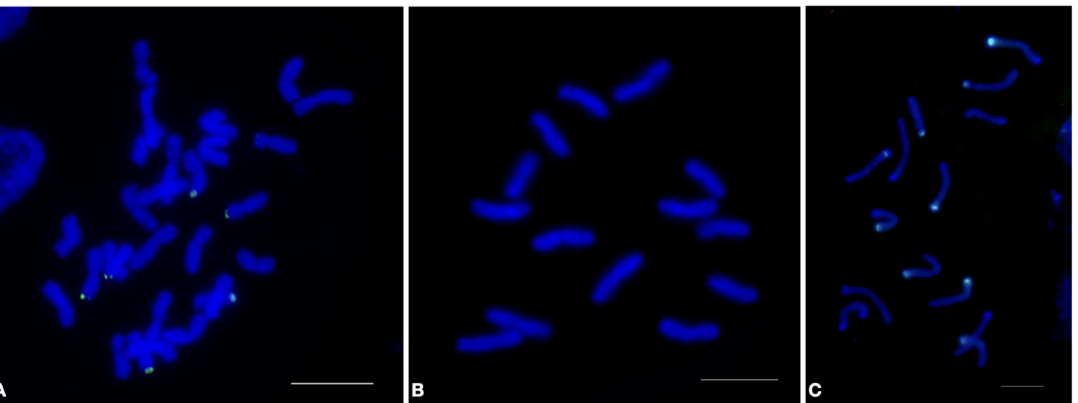
Figure 4. Localization of CL244 tandem repeat on metaphase chromosomes of ( A )— Aegilops crassa AE 742; ( B )— Aegilops tauschii K-112; ( C )— Thinopyrum bessarabicum PI 201890, using fluorescence in situ hybridization. Green signals show chromosomal localization of CL244 tandem repeat, bar indicates 10 µ m.